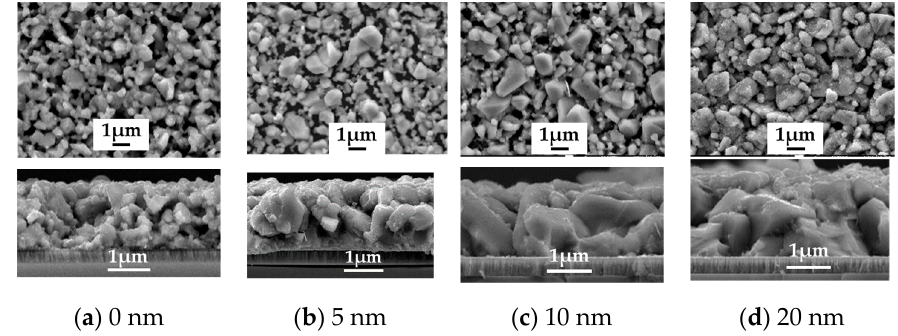
Figure 7. Surface and morphology of the AIGS films showing the important role of the Na 2 Se post-deposition process. ( a ) No Na 2 Se post-deposition. Na 2 Se thicknesses of ( b ) 5, ( c ) 10, and ( d ) 20 nm.